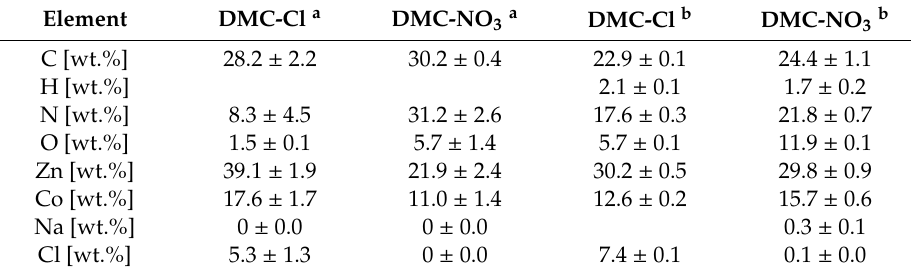
Figure 8. SEM images with 20,000 magnitude of enlargement of DMC-Cl ( a ) and DMC-NO 3 ( b ). Table 9. Elemental composition of DMC-Cl and DMC-NO 3 .